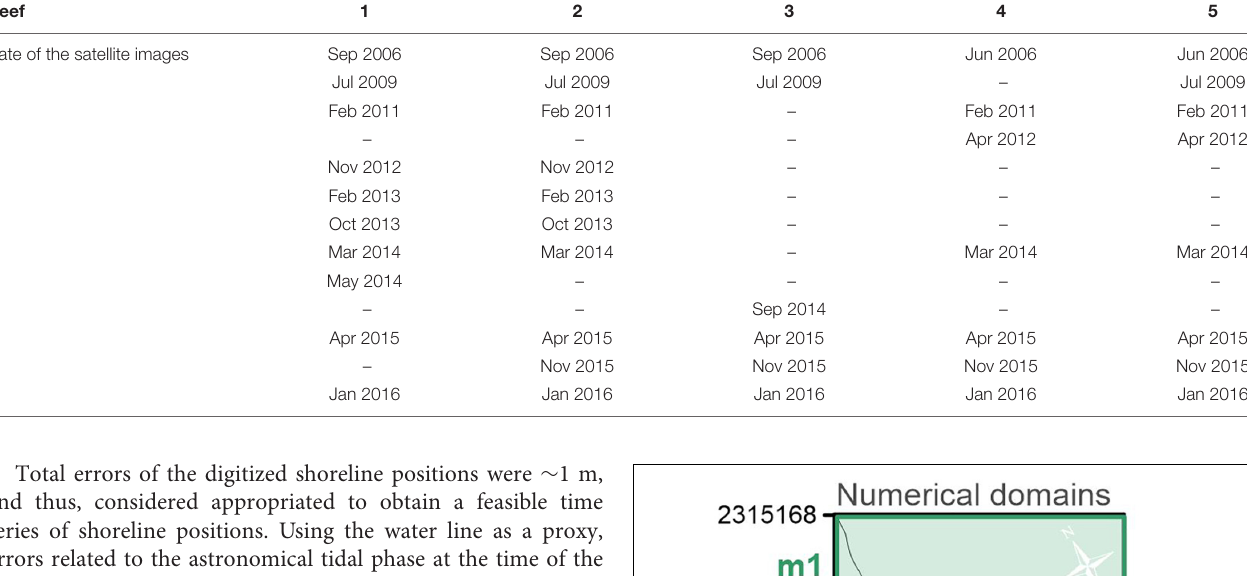
TABLE 2 | Data used for the analysis of shoreline change. Reef